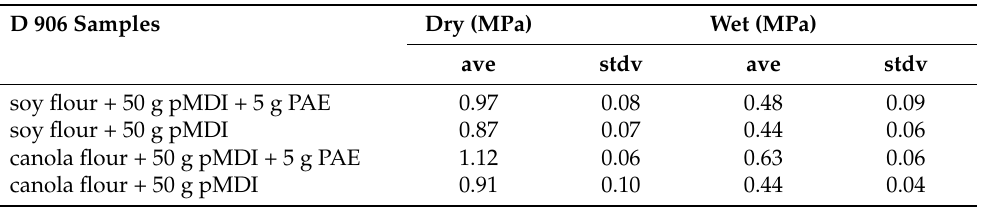
Table 4. D 906 plywood test results of soy and canola flour (25% flour solids) dry and wet strength (MPa).